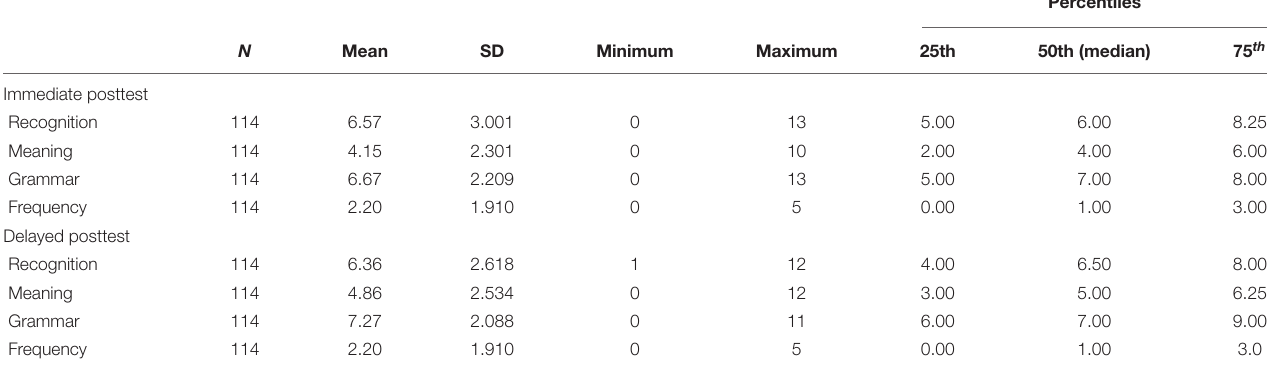
TABLE 5 | Descriptive statistics for frequency of